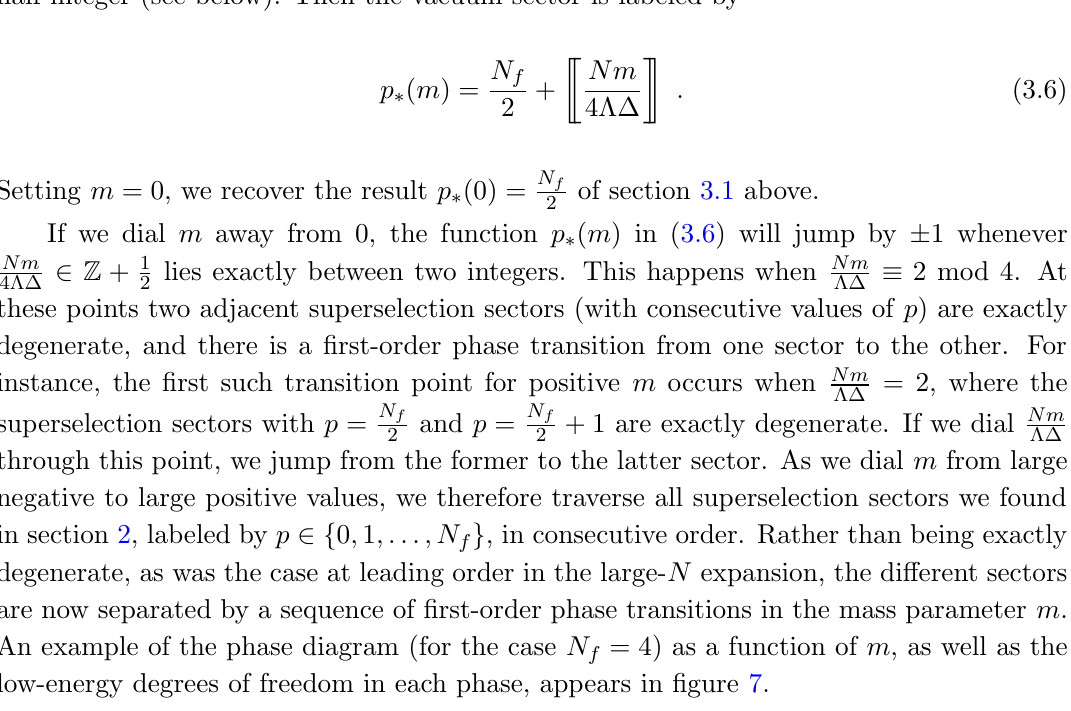
Figure 7 . The potential (3.5) as a function of m in the di(cid:11)erent superselection sectors for N First-order phase transitions are indicated by black dots. The black line represents the true